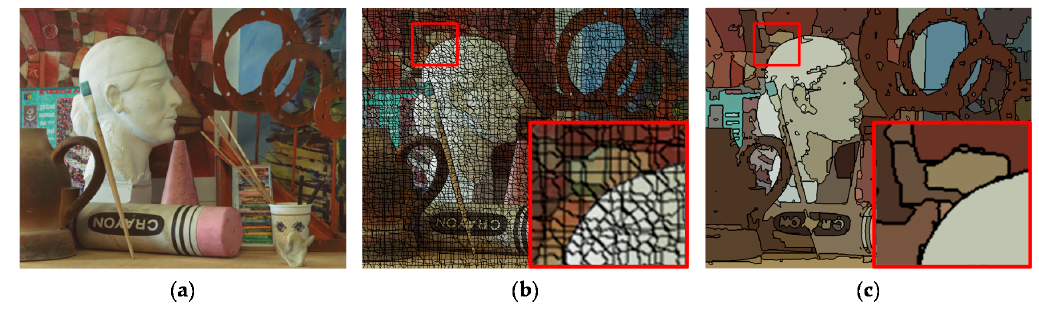
Figure 4. ( a ) Input MV LDR image, I m ; ( b ) luminance channel of I m and L m ; and ( c ) under/over-exposed region map, S .